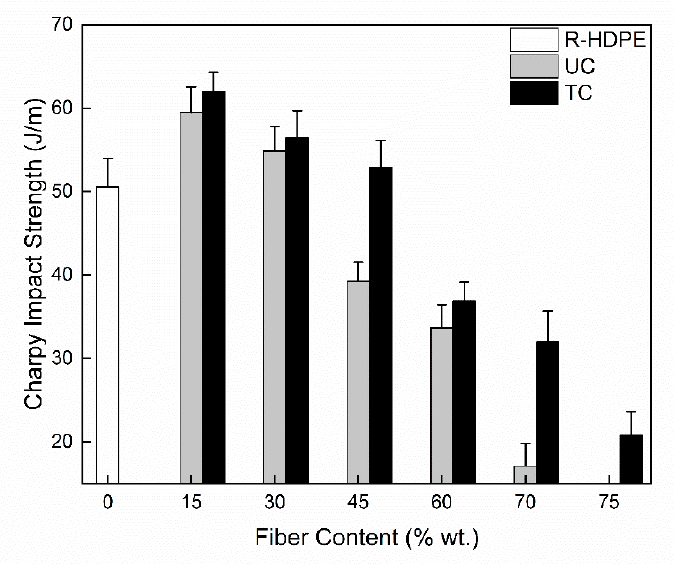
Figure 14. Charpy impact strength for recycled high-density polyethylene (R-HDPE), untreated (UC) and treated (TC) composites as a function of fiber content.